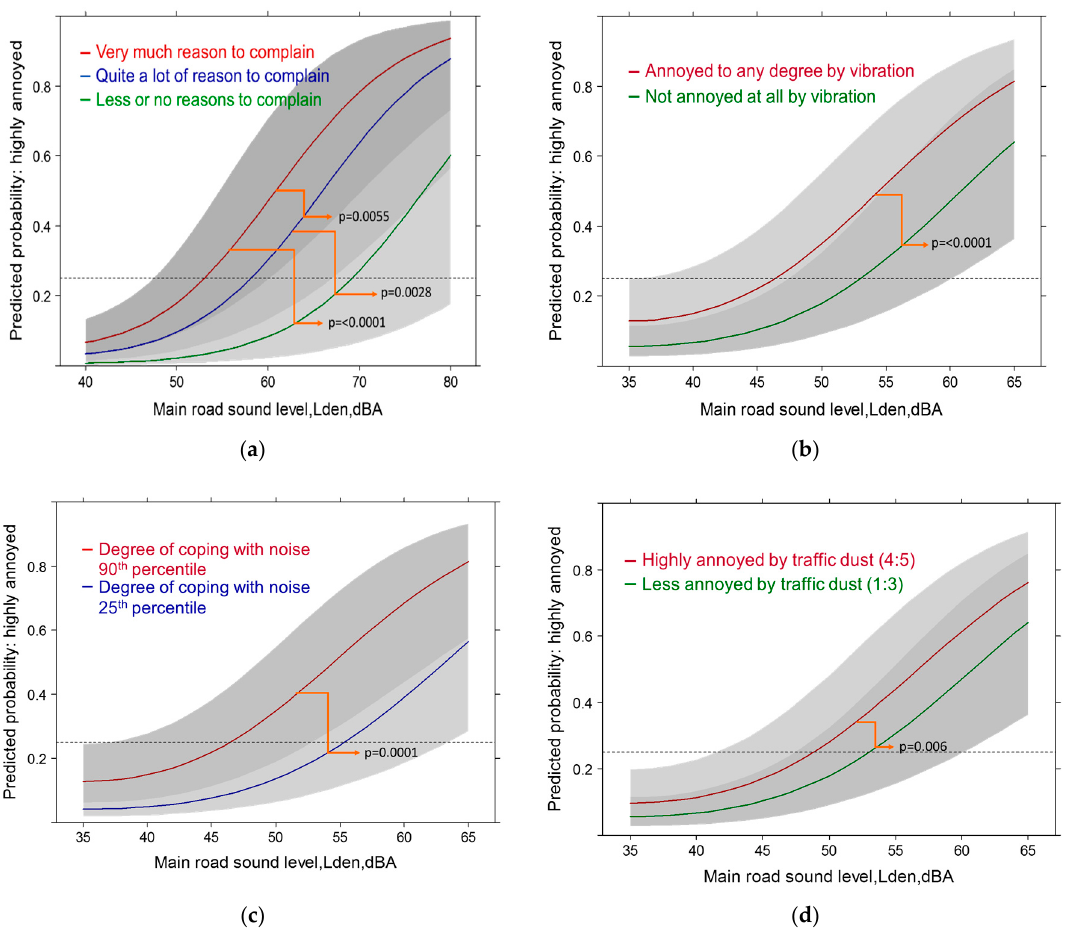
Figure 14. Predicted probability of high annoyance associated with main road sound exposure by ( a ) complaints about community soundscape and; ( b ) perceived vibration. Models are adjusted for age, gender, education, health status, sleep score, distance to sources, sensitivity to noise and air pollution, complaints (not a), living duration, anger at traffic load, perceived vibration (not b ), perceived air pollution from road, general satisfaction with life, location of traffic tracks, region and air pollution (annual NO 2 values). Predicted probability of high annoyance during the past year associated with main road sound exposure by; ( c ) coping efforts and ( d ) perceived dust/soot exposure. Models are adjusted for age, gender, education, health status, sleep score, distance to all sources, sensitivity to noise and air pollution, coping score (not c ), living duration, anger at traffic load, perceived air pollution from road (not d ), general satisfaction with life, location of traffic tracks, region and air pollution (annual NO 2 values).